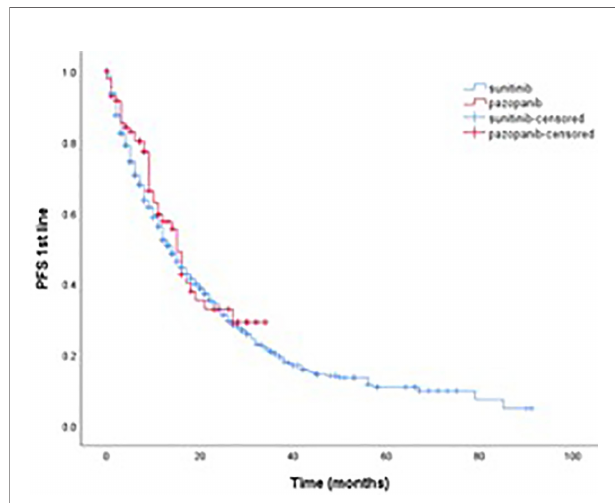
FIGURE 1 | Kaplan – meier estimate of PFS for fi rst-line sunitinib and pazopanib.